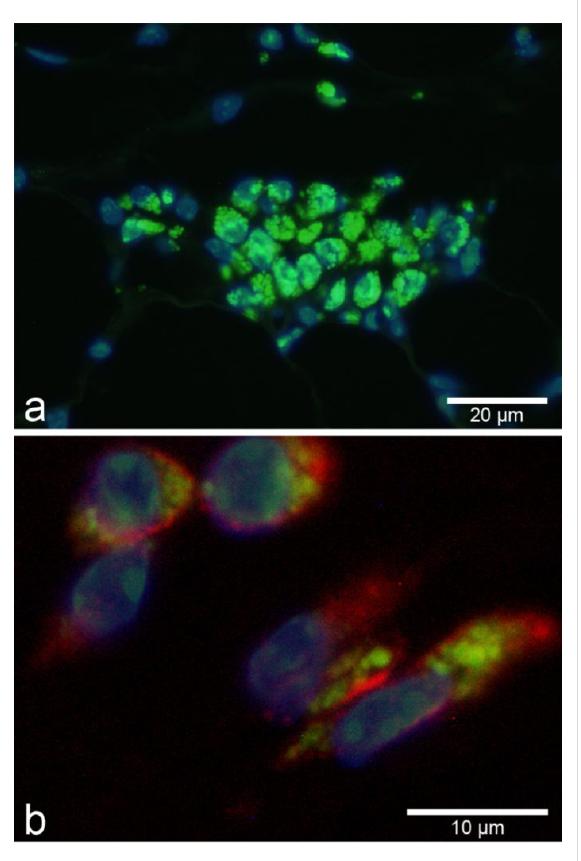
Figure 3: Aggregates of FITC-labeled SiO 2 -NP (green, 55 ± 6 nm in diameter) were visualized by fluorescence microscopy in macrophages following subcutaneous injection (a). Nuclei were counterstained with DAPI (blue). Subsequent immunofluorescent labeling (red) for the macrophage marker F4/80 identified macrophages as uptaking cells